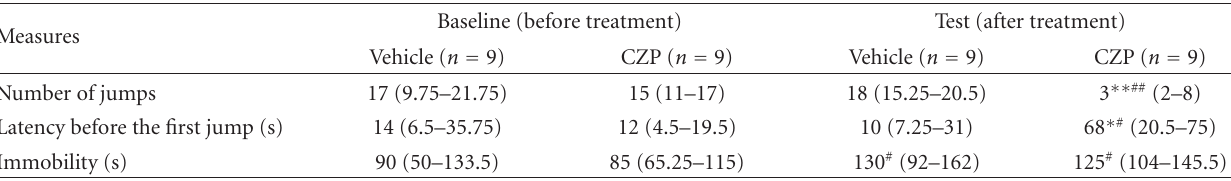
Table 5: E ff ects of acute clonazepam (CZP) treatment (1mg/kg, IP, n = 9, median with limits of interquartile range values). Mann-Whitney